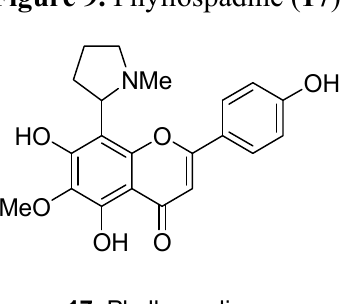
Figure 9. Phyllospadine ( 17